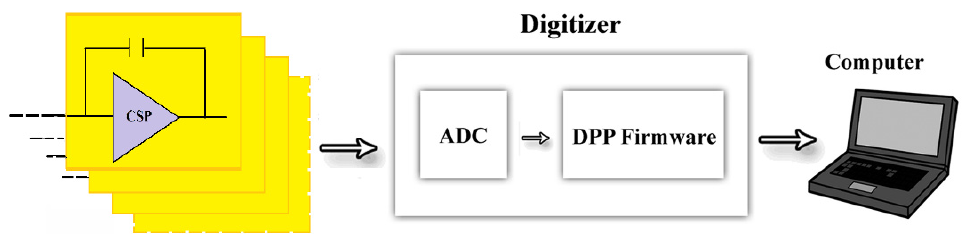
Figure 2. Schematic view of the readout electronic circuit architecture. On the left, there is the charge-sensitive preamplifiers of the PIXIE ASIC [47], where the CZT pixels were flip-chip bonded; the pulse shaping and the pulse height analysis was performed by custom digital pulse processing electronics [48–50] controlled through a PC.